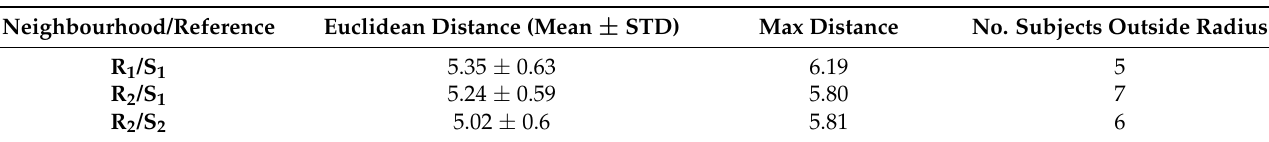
Table 8. Euclidean Distance of RBD subjects in the CAP Database. Summary of the tested neighbour- hood/reference combinations.